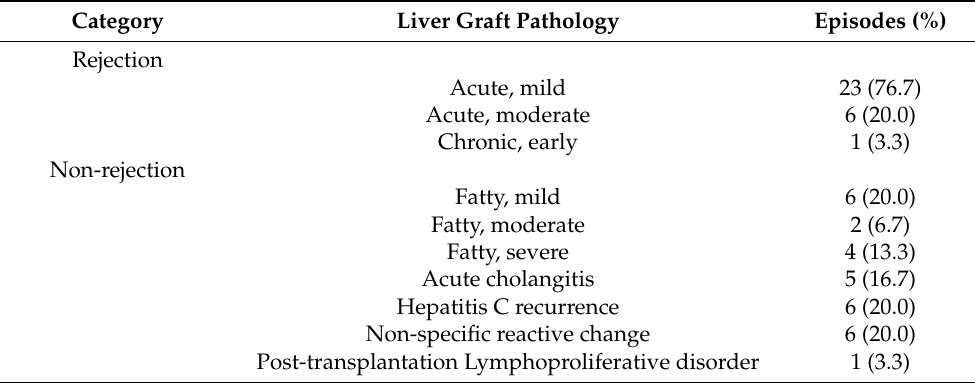
Table 1. Liver graft pathologies of rejection ( n = 30) and non-rejection ( n = 30) in the recipients who underwent living donor liver transplantation.